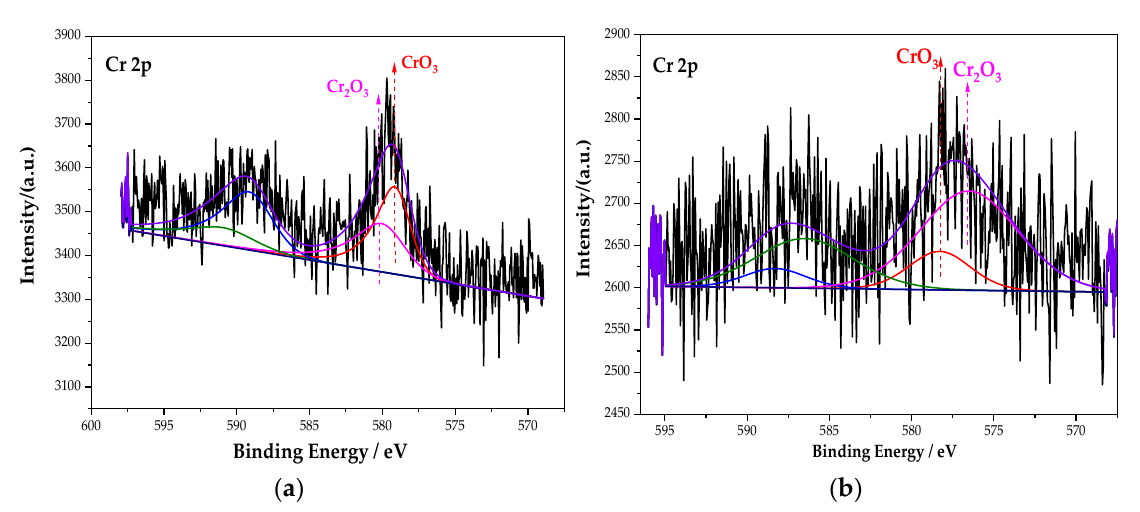
Figure 8. XPS peak spectrum of the Cr element in the passive film under the action of different rust inhibitors. ( a ) Na 2 CrO 4 group. ( b ) Na 2 CrO 4 + BTA Table 6. Fitting data of the Cr element in different groups.